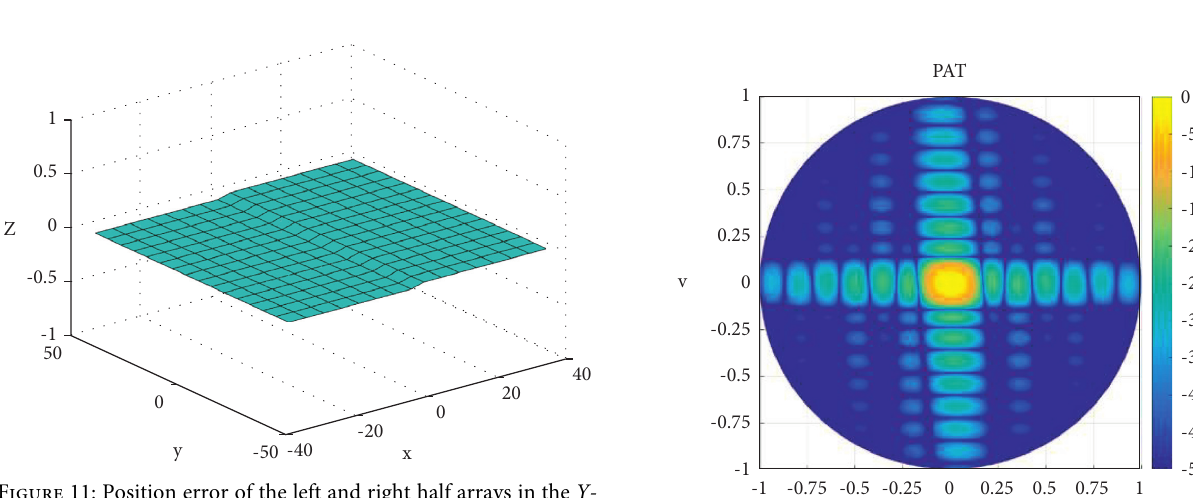
Figure 10: Changes in technical indicators caused by the position error of the left and right half arrays in the X -direction. (a) Gain. (b) Sidelobe level. (c) Beam width. (d) Beam pointing.